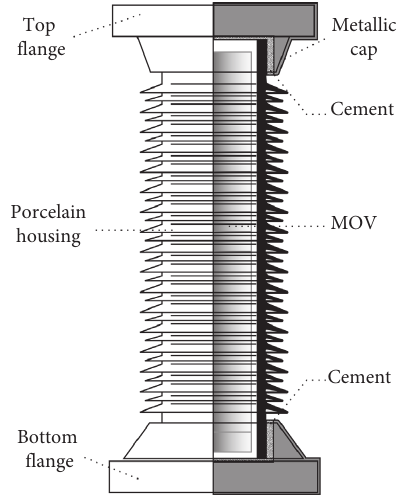
Figure 3: Structural schematic of one porcelain arrester